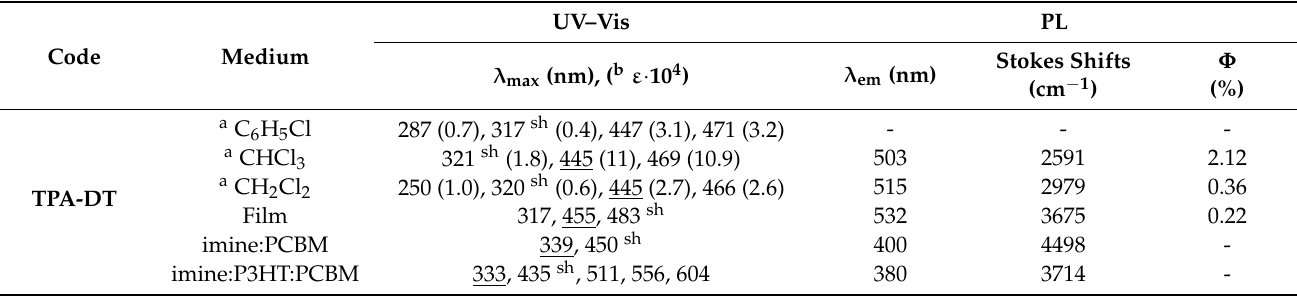
Table 3. UV–vis and PL data of the